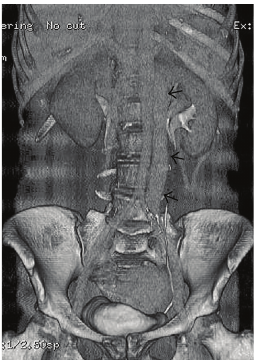
Figure 1: Left inferior vena cava (black arrows).